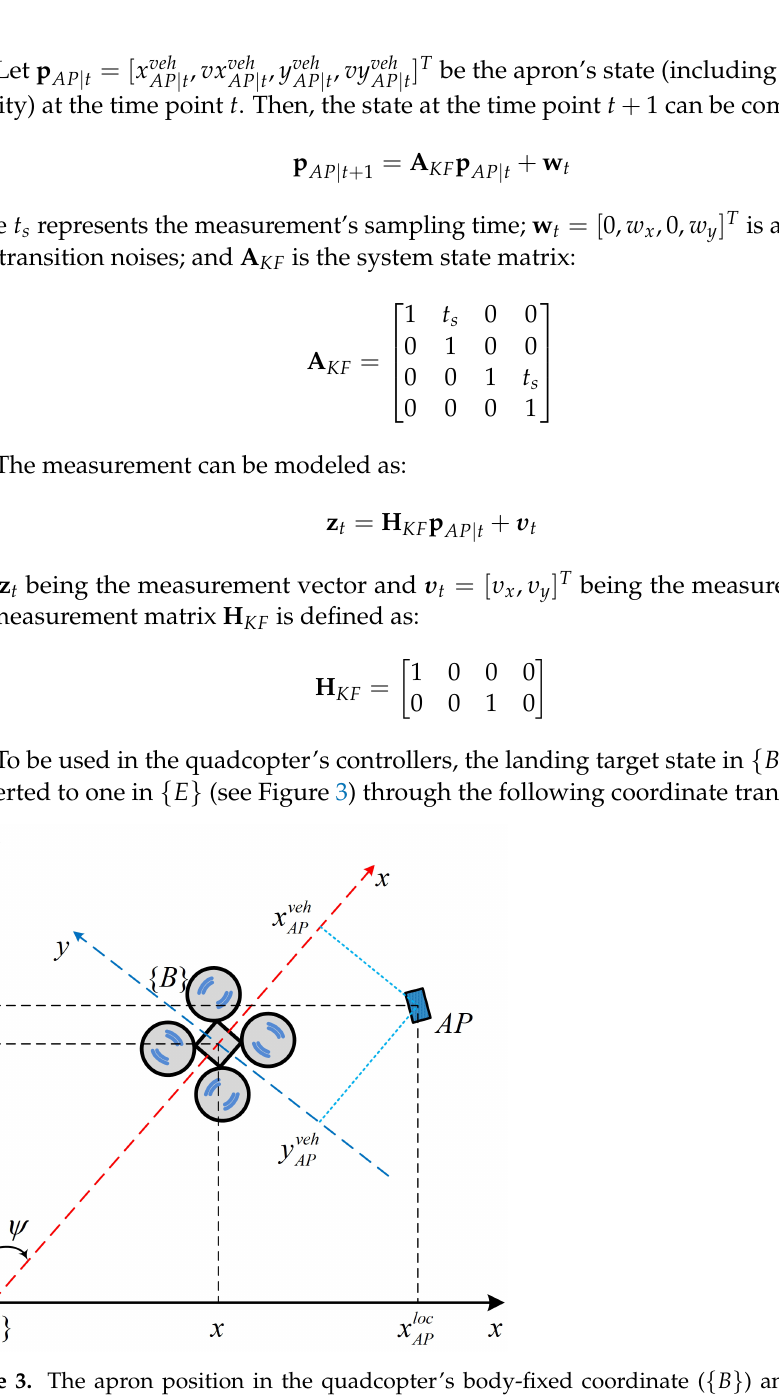
Figure 3. The apron position in the quadcopter’s body-fixed coordinate ( { B } ) and in the local earth-fixed coordinate ( { E }